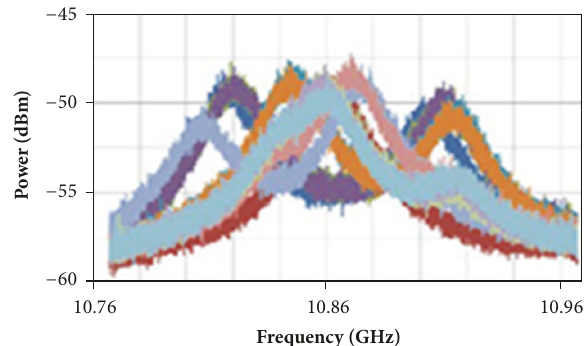
Figure 9: High resolution heterodyne measurement of SBS shift in several lengths of the same (Corning SMF-28) single mode fiber [adapted from